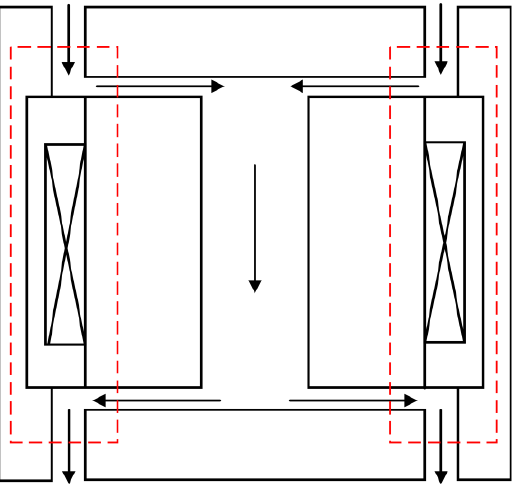
Figure 6. Mixed-channel structure.